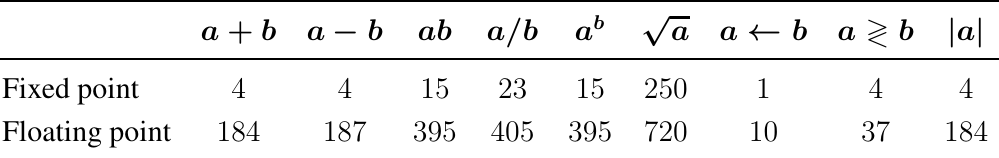
Table 2. Telosb operation